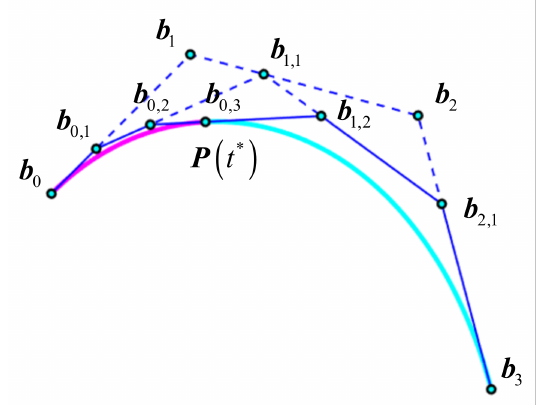
Figure 9. Symmetric typical B é zier curve with k = 10 when s = 1. ( a ) θ = − π /6 and ∆ b ( b ) symmetric curvature plot with a local minimum at t = 0.5.